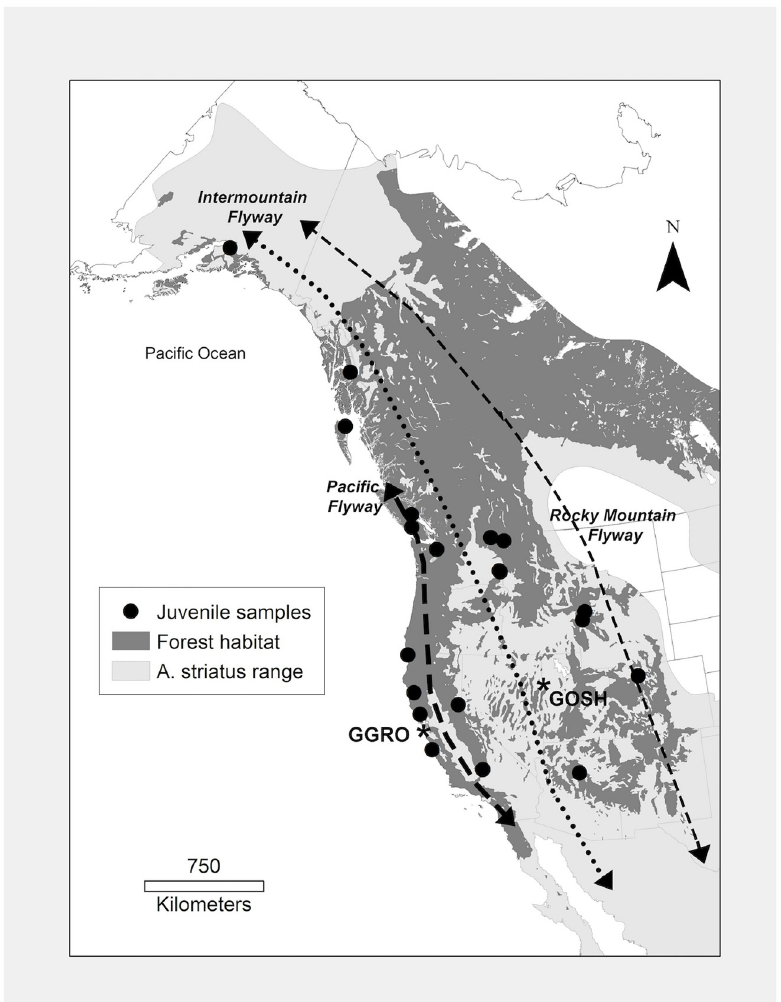
Fig 1. Map of sample locations for museum specimens of juvenile Sharp-shinned Hawk ( Accipiter striatus ) feathers. Museum specimens mapped in reference to the species known range in Western North America (light gray), and suitable forest habitat (dark gray). Juvenile samples ( n = 23) are shown as circles. Collection sites of migratory bird samples are indicated as GGRO (Golden Gate Raptor Observatory) and GOSH (Goshutes Mountains). The dominant migratory flyways of western North America are indicated by dashed lines and modified from Hoffman et al. (2002) for illustrative purposes. State and country boundaries are modified from public domain GIS files, US Census Bureau (2016) and Natural Earth (2020). Species range acquired with permission from BirdLife International and NatureServe (2015), and data to create the GIS biome layer acquired from Brown, Bennan, and Unmack (2007).